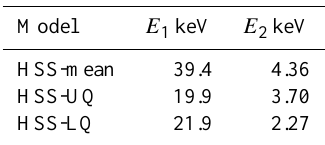
Table 3. Characteristic energies for the exponential ( E 1 ) and power- law tail ( E 2 ) parts for the flux-energy distribution of energetic elec- trons (Eqs. 1 and 2) used to estimate electron density profiles. The three alternatives are fits to the mean (“HSS-mean”), upper-quartile (“HSS-UQ”) and lower-quartile (“HSS-LQ”) integral fluxes in the statistical study of electron precipitation during HSS by Meredith et al.